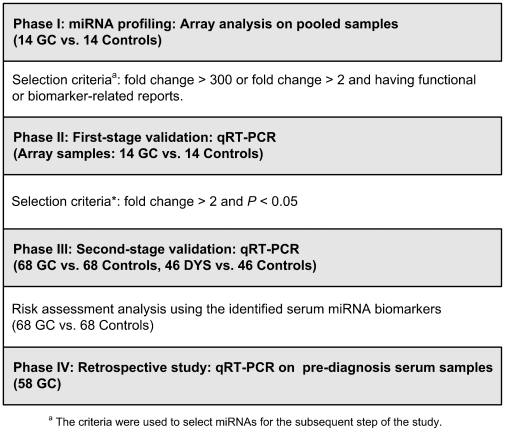
The flow chart of the study design.